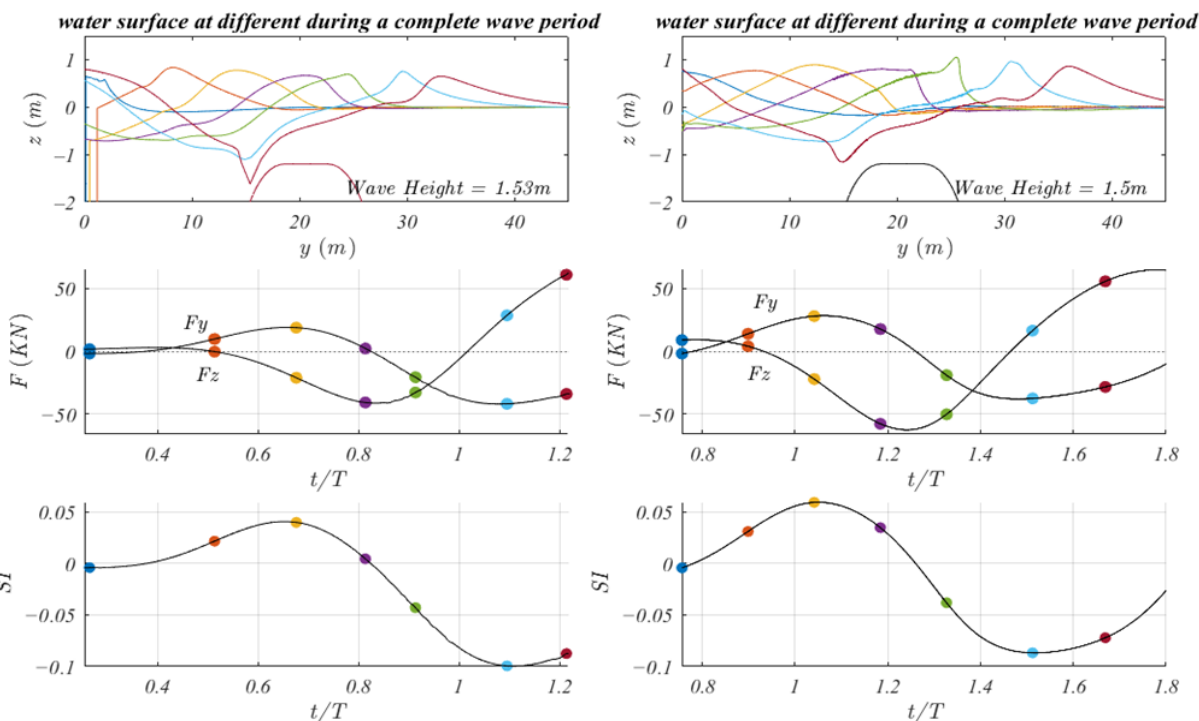
Figure 8. Water surface elevations, loads and SI for wave height 1.36 m and 1.39 m, T = 7 s, as obtained by BELWF (left) and by OpenFOAM (right), respectively.